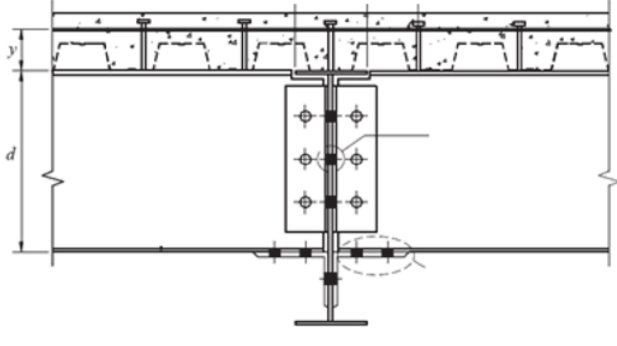
(adapted from ABNT NBR 8800